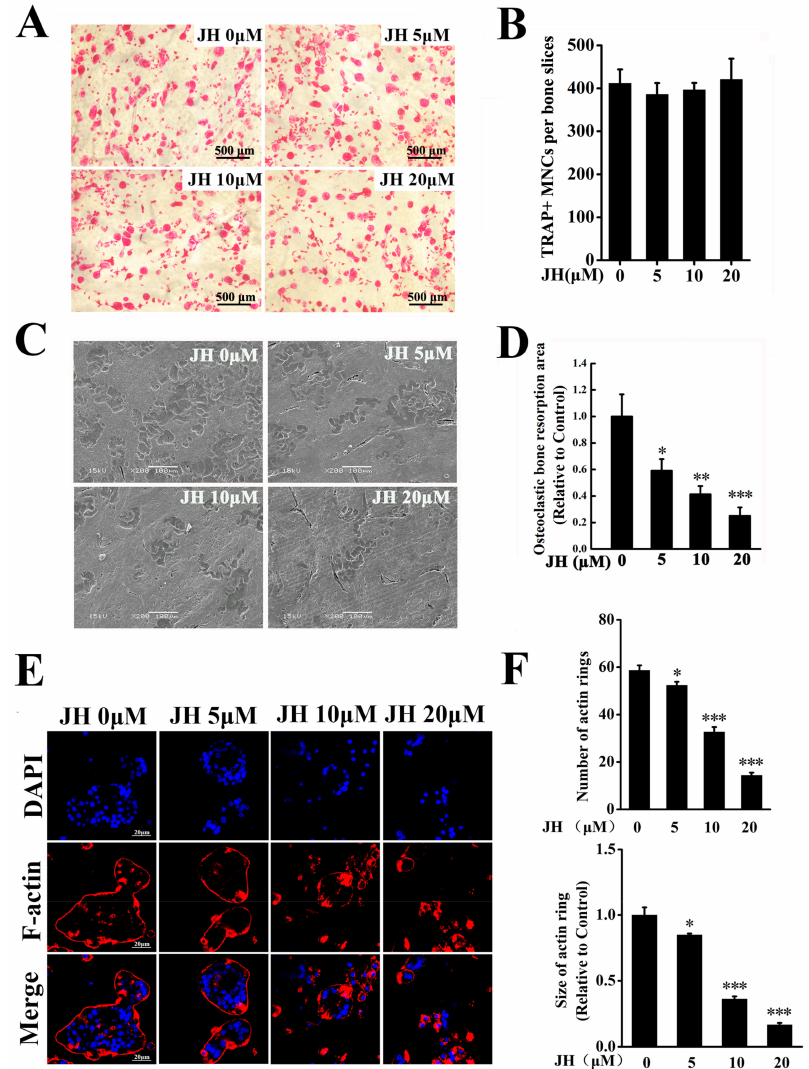
Figure 4. JH inhibits osteoclast-mediated bone resorption. ( A ) Representative TRAP staining images showing no cytotoxic effect of JH on mature osteoclasts. ( B ) The number of TRAP + osteoclasts ( ≥ 3 nuclei) from ( A ) were quantified ( n = 3). ( C ) Representative scanning electron microscopy (SEM) images showing the inhibitory effect of JH on osteoclast-mediated bone resorption. ( D ) Resorption area relative to the total area of bone was measured using ImageJ ( n = 3). ( E ) Representative immunofluorescence staining images showing the inhibitory effect of JH on F-actin ring formation. ( F ) The number and size of intact actin rings from ( E ) were quantified ( n = 3). * p < 0.05, ** p < 0.01 and *** p < 0.001 relative to RANKL-treated, JH-untreated